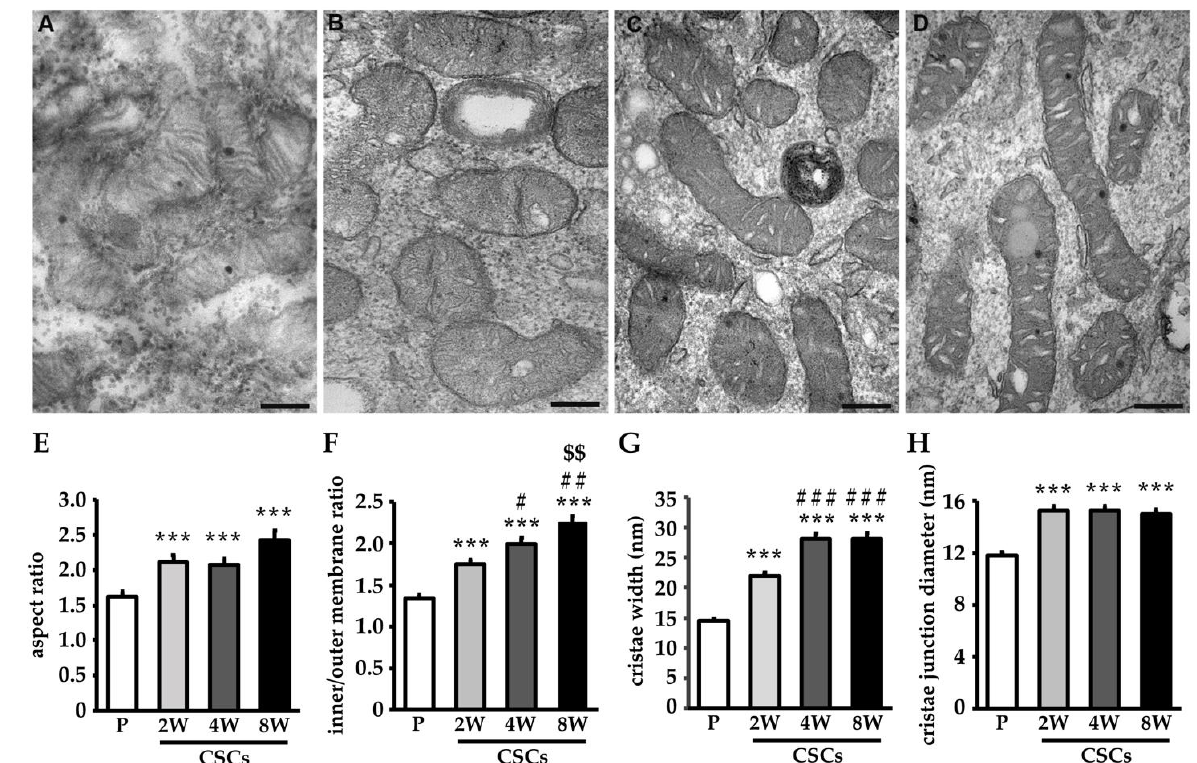
Figure 3. CSCs show alterations of mitochondria structure. Representative transmission electron micrographs of mitochondria of Panc1 parental cells ( A ), and CSCs at 2 weeks ( B ), 4 weeks ( C ), and 8 weeks ( D ) of culture. Scale bar = 200 nm. The histograms represent the means of the aspect ratio (major axis/minor axis length) ( E ), the mitochondrial inner/outer membrane ratio ( F ), the mitochon- drial cristae width ( G ), and the mitochondrial cristae junction diameter ( H ). Histogram legends: white: P cells; light gray: CSCs 2 weeks (2W); dark grey: CSCs 4 weeks (4W); black: CSCs 8 weeks (8W). Bars indicate the mean ± SEM of the indicated samples. Statistical legends: Parental vs. CSCs = *** p < 0.001; 2W CSCs vs. CSCs = # p < 0.05, ## p < 0.01, ### p < 0.001; 4W CSCs vs. CSCs = $$ p < 0.01.